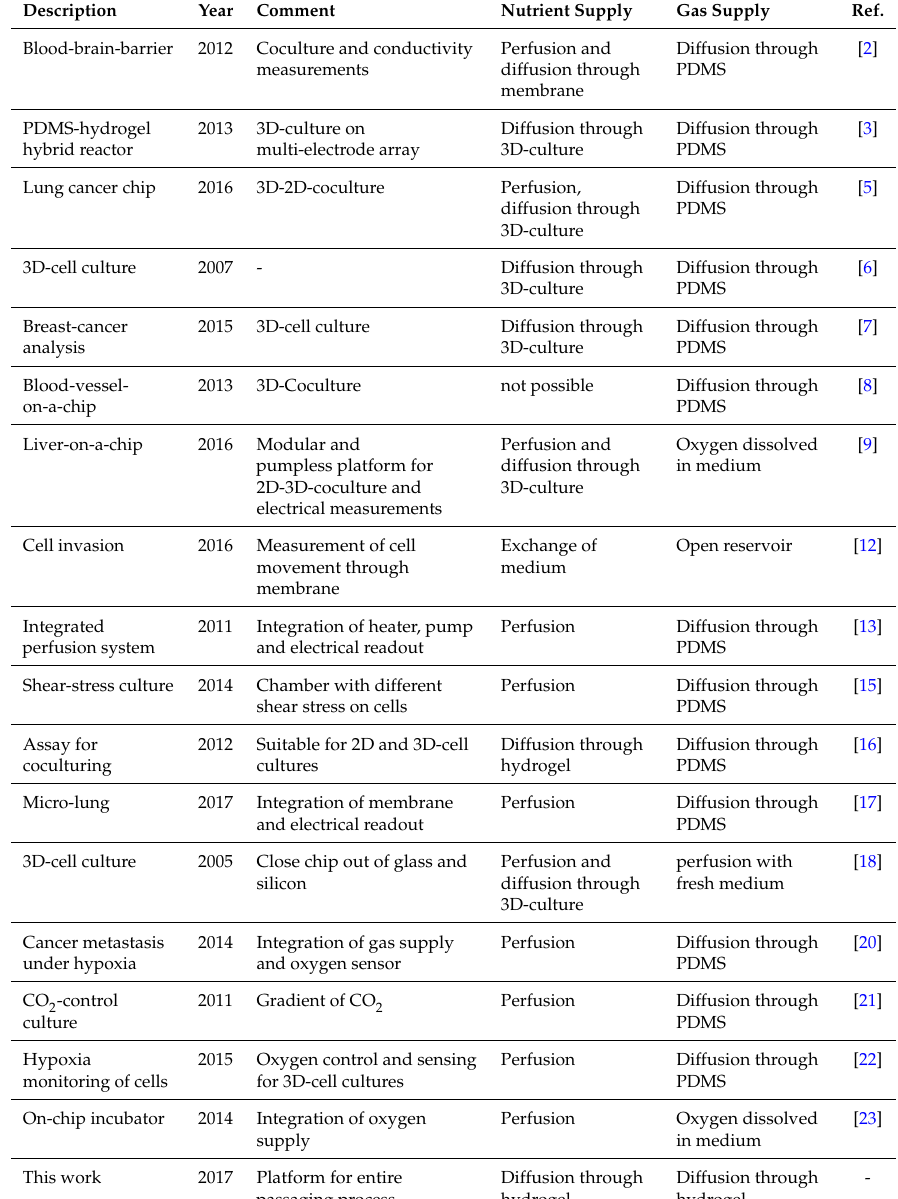
Table 1. Comparison of different Lab-on-a-chips (LoC) for the long-term cultivation of mammalian cells.